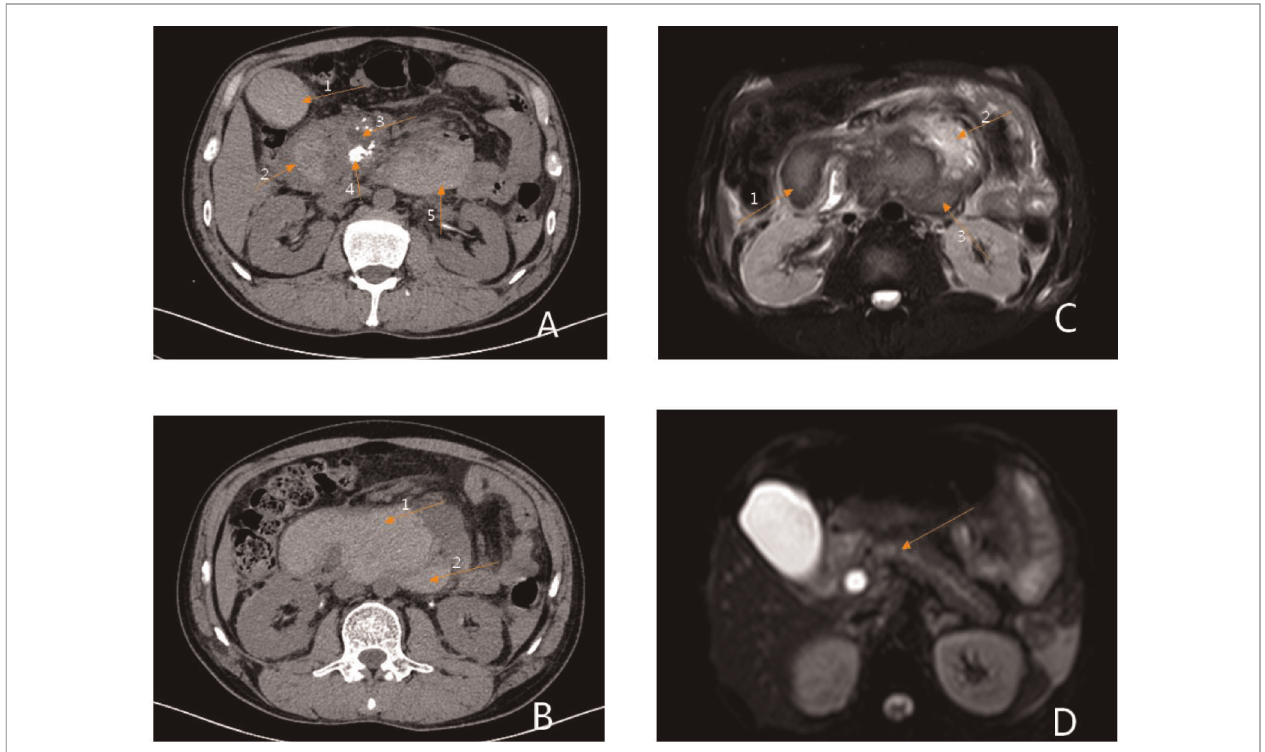
FIGURE 1 | Preoperative imaging fi ndings. ( A ) Phase III dynamic enhanced abdominal CT: Arrow 1 shows an intragallbladder hematoma, arrow 2 shows an intraduodenal hematoma, arrow 3 shows dilation of the main pancreatic duct, arrow 4 shows uneven enhancement of the head of the pancreas, suggestive of pancreatitis, and arrow 5 shows a retroperitoneal hematoma. ( B ) Phase III dynamic contrast-enhanced abdominal CT: Arrow 1 shows an intraintestinal hematoma, arrow 2 shows a retroperitoneal hematoma. ( C ) Abdominal MRI: Arrow 1 shows an intraduodenal hematoma, arrow 2 shows normal pancreatic tissue, and arrow 3 shows a retroperitoneal hematoma. ( D ) Abdominal MRI: This image shows a fully distended pancreatic